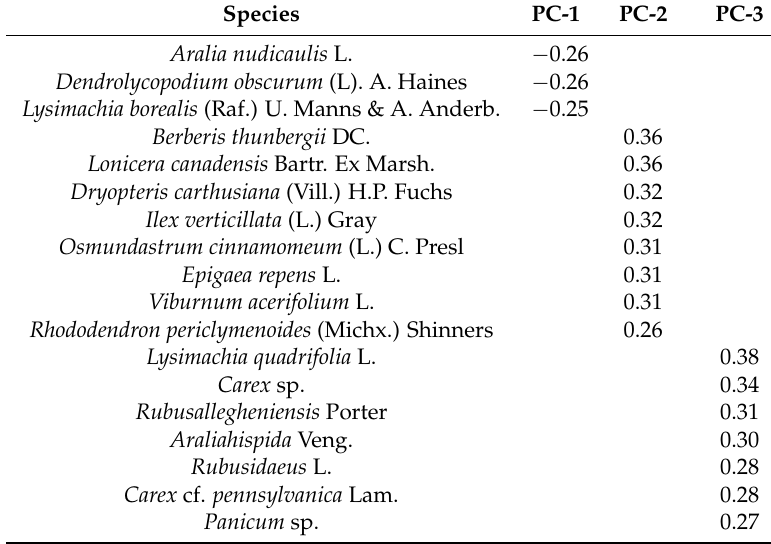
Table 2. Loadings of species on each of the three principal components axes illustrated in Figure 2. Only species for which the absolute value of the loading ě 0.25 are